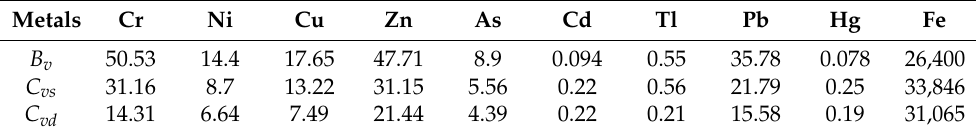
Figure 1. Vertical variations of heavy metals in sediments, all data in mean concentrations, dry weight, mg/kg. The boxes represent 25th and 75th percentiles, the middle horizontal lines represent the 50th percentile, the vertical line ends represent 1st and 99th percentiles, the small squares in the middle represent the mean value, and the diamond black dots represent outliers. Table 1. Comparison of three types of background values of heavy metals and Fe in sediments, including soil background value ( B v ), control value of surface sediment ( C vs ), and control value of deep sediment ( C vd ) in Guangdong Province, dry weight,